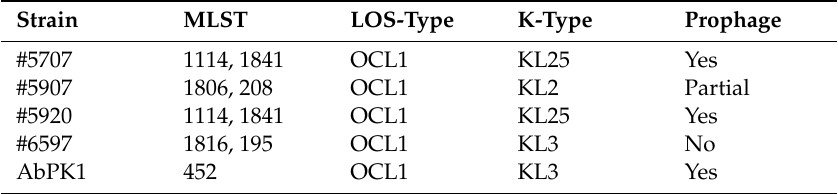
Table 4. Whole genome sequence data based overview of A. baumannii